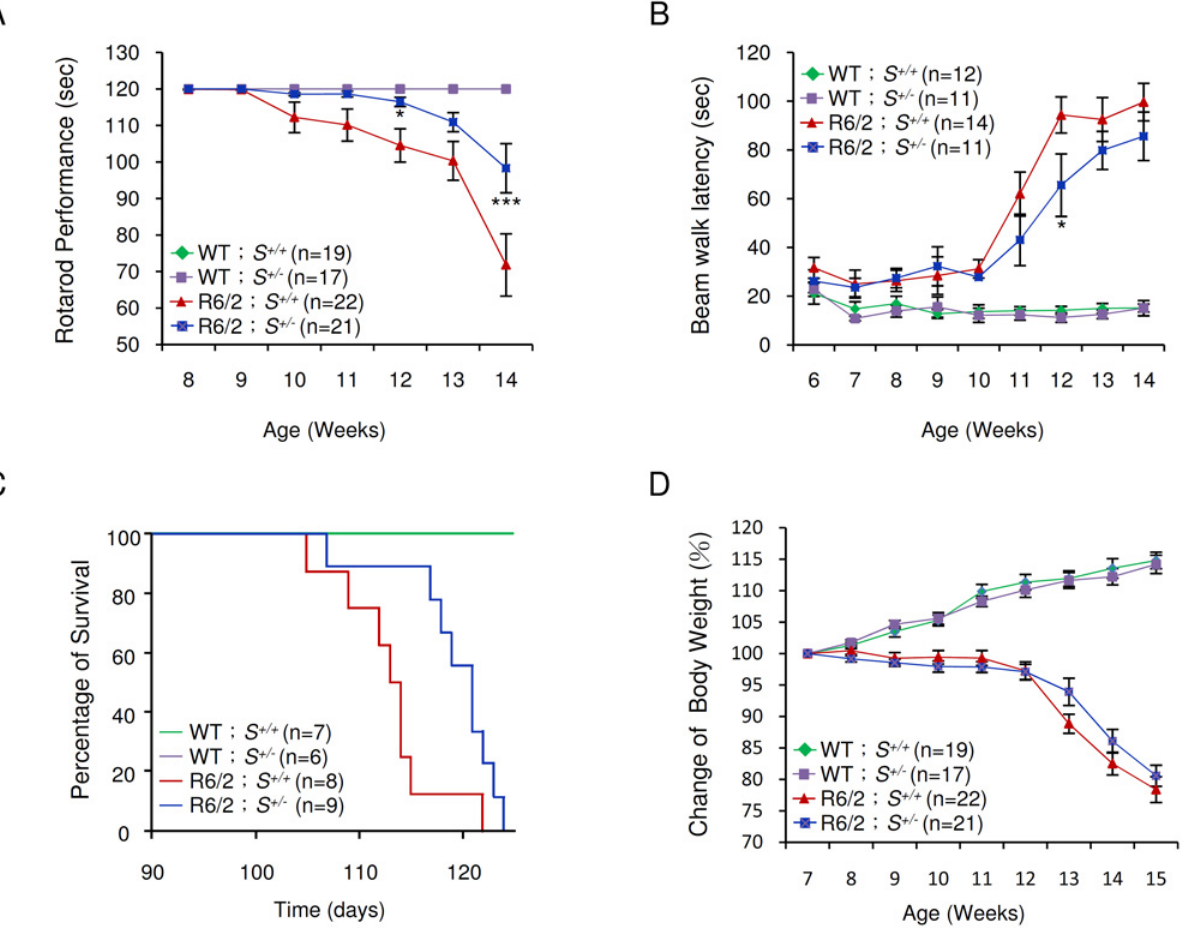
Fig 5. Effect of Supt4h deletion on motor function and lifespan of R6/2 mice. (A) Mice at the age of 8 to 14 weeks were tested for rotarod performance as described in Materials and Methods. (B) Latency of indicated animals, at the age of 6 to 14 weeks, on beam walking was analyzed. Data are presented as the mean ± SEM. * , p < 0.05; *** , p < 0.001 in comparison with R6/2 S +/+ mice, using two-way ANOVA followed by Bonferroni post hoc test. (C) Longevity of indicated animals was recorded. Compared to R6/2 S +/+ mice, HD animals with a single allele of Supt4h deletion (R6/2 S +/- ) showed a longer lifespan ( p = 0.0204, Log-rank test). (D) Body weight was measured weekly and its change relative to the body weight at the age of 7 weeks is shown. Results were collected from mice at 7 through 15 weeks of age. The number of mice (n) used in each individual assay is indicated.